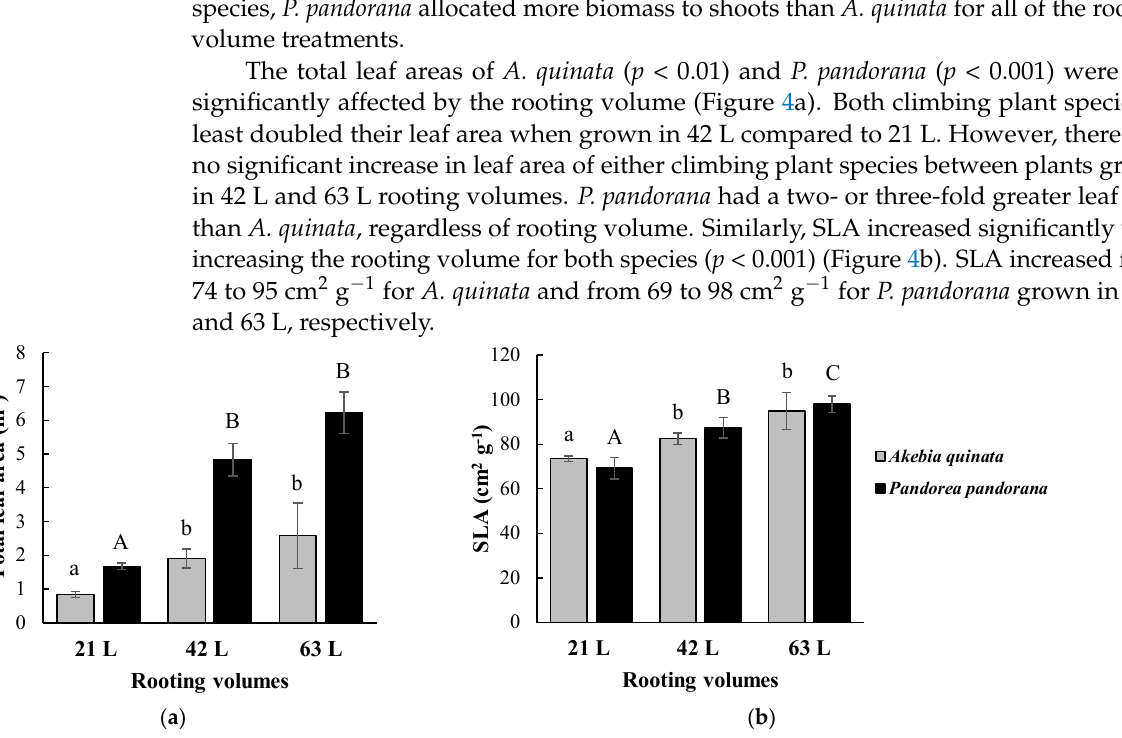
Figure 4. Average total leaf area ( a ) and average specific leaf area (SLA) ( b ) of Akebia quinata and Pandorea pandorana grown in three different rooting volumes after six months of growth. Values are means ± SE. Different letters represent significant differences within species, p < 0.001; lowercase, Akebia quinata ; capital, Pandorea pandorana .